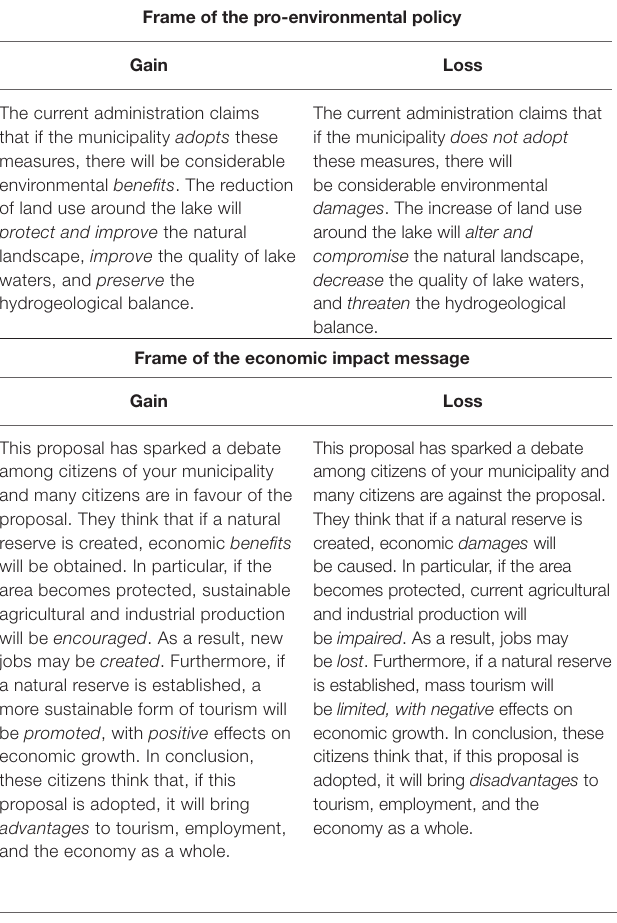
TABLE 4 | Framing of the pro-environmental policy proposal and of the economic impact message.